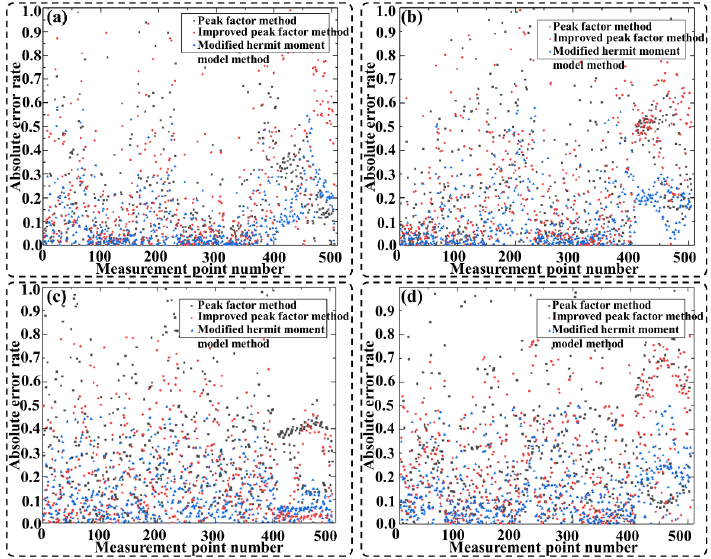
Figure 12. Absolute error rate of each measurement point: ( a ) 0° wind direction angle; ( b ) 30° wind direction angle; ( c ) 60° wind direction angle; ( d ) 90° wind direction angle.